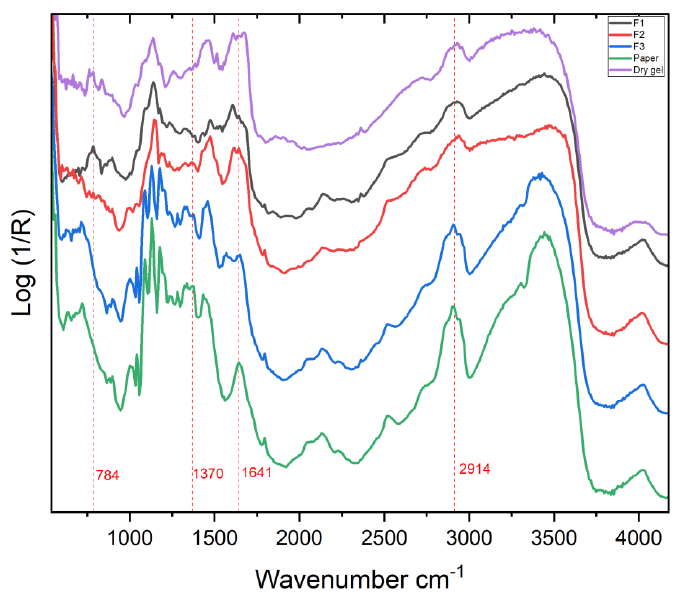
Figure 5. FTIR spectra of points F1, F2, F3, paper, and the dry obtained from the mock-up sample. F1 differentiates from F3 and the paper from the fact that the peaks at 1088 and 1177 cm ₋ 1 in F1 are way less intense; meanwhile, the peak, found in F3 and paper at 1129 cm ₋ 1 , is shifted to 1145 cm ₋ 1 in F1 and F2. The peak at 1281 cm ₋ 1 was found in F3, and the